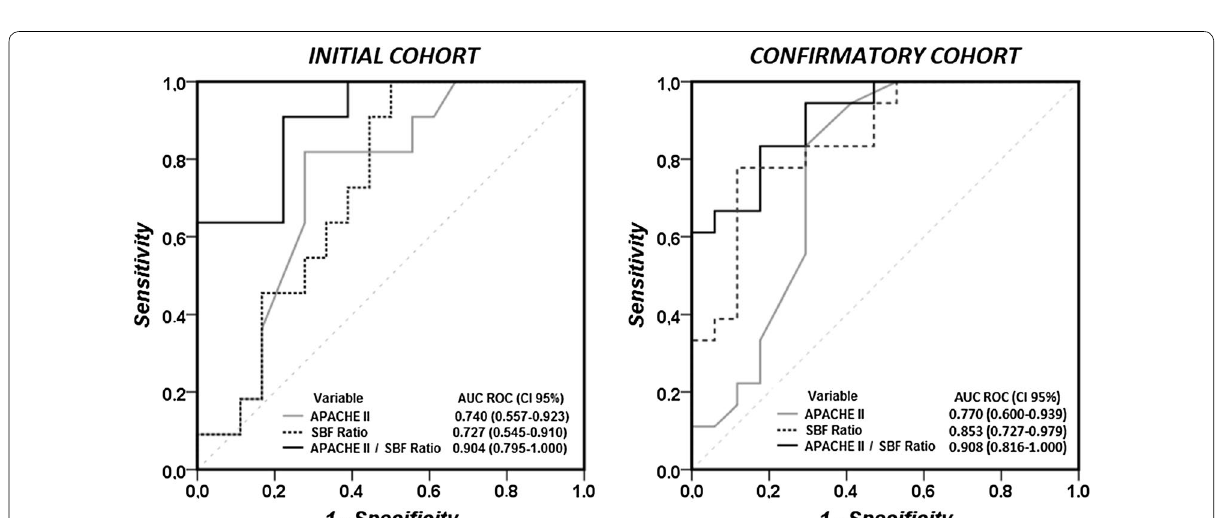
Fig. 3 Receiver operating characteristic (ROC) curves for the predictive value of the APACHE II score, the skin blood flow (SBF) ratio and the APACHE II/SBF ratio (initial and confirmatory